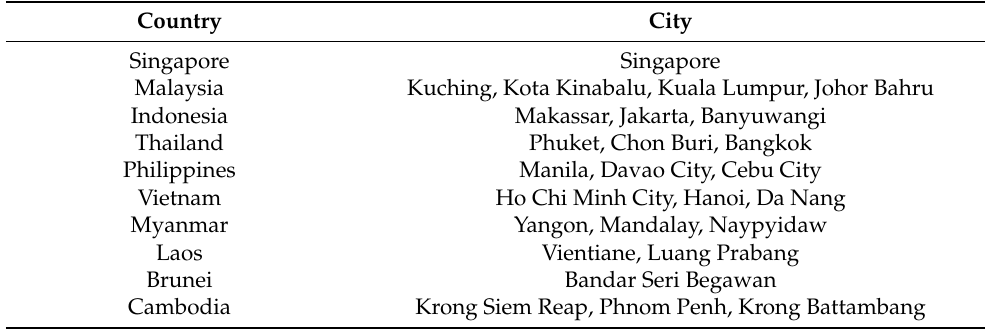
Table 5. Ongoing and planned smart cities in Southeast Asia